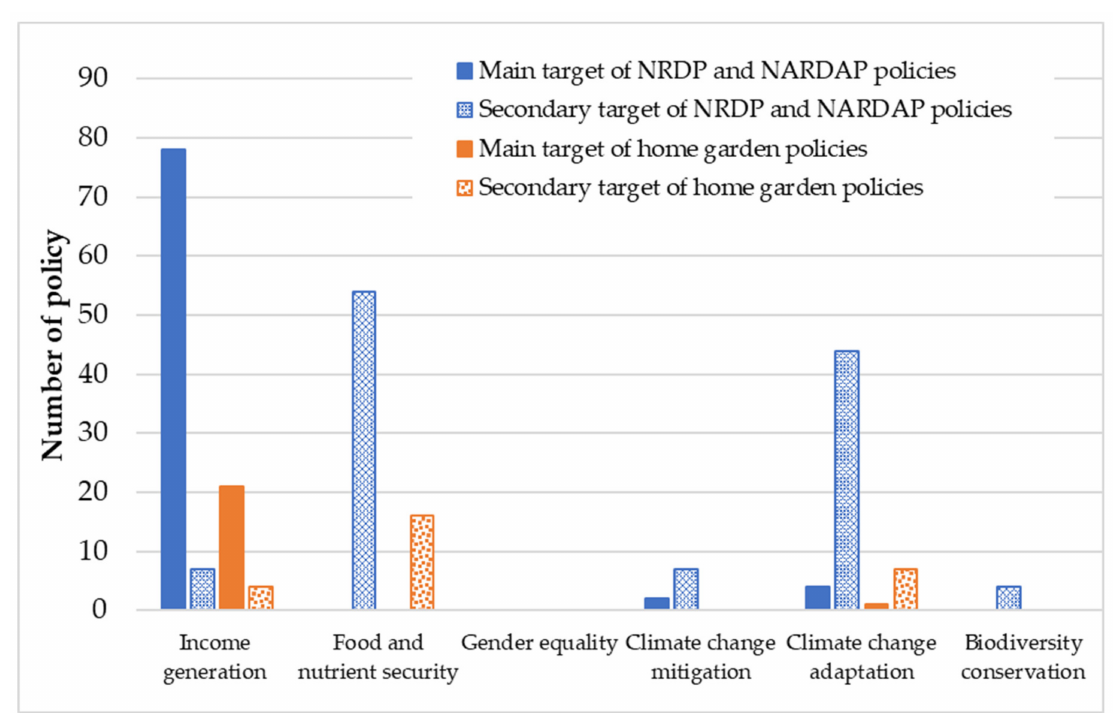
Figure 2. Main and secondary targets of the reviewed policies (the New Rural Development Programs (NRDP) and National Agriculture Restructuring and Development of Other Agriculture Programs (NARDAP) policies include home garden